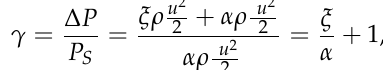
Table 4. The calculation results of quality factor 𝑌 .